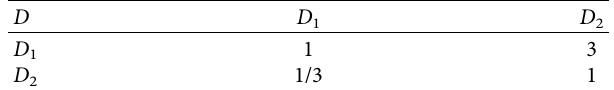
Table 19: D-D 1-2 judgment matrix.